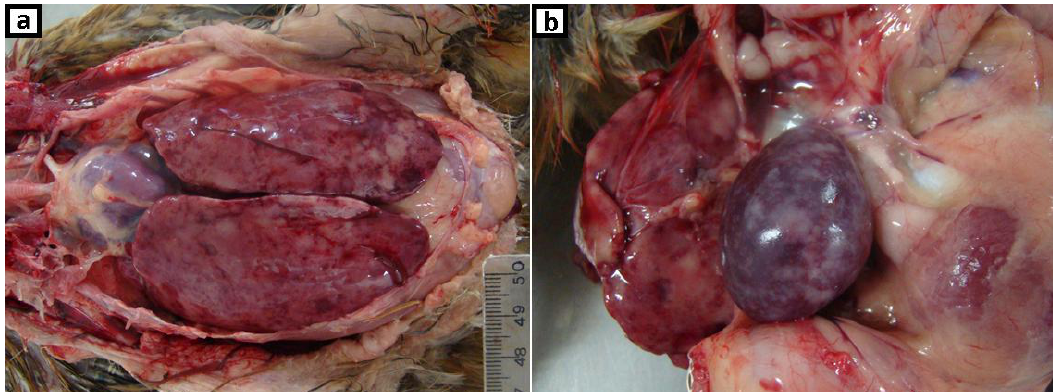
Figure 1. Gross, hen, 12-weeks-old. Multifocal to coalescing white foci associated with ( a ) marked enlarged liver, ( b ) marked enlarged spleen.